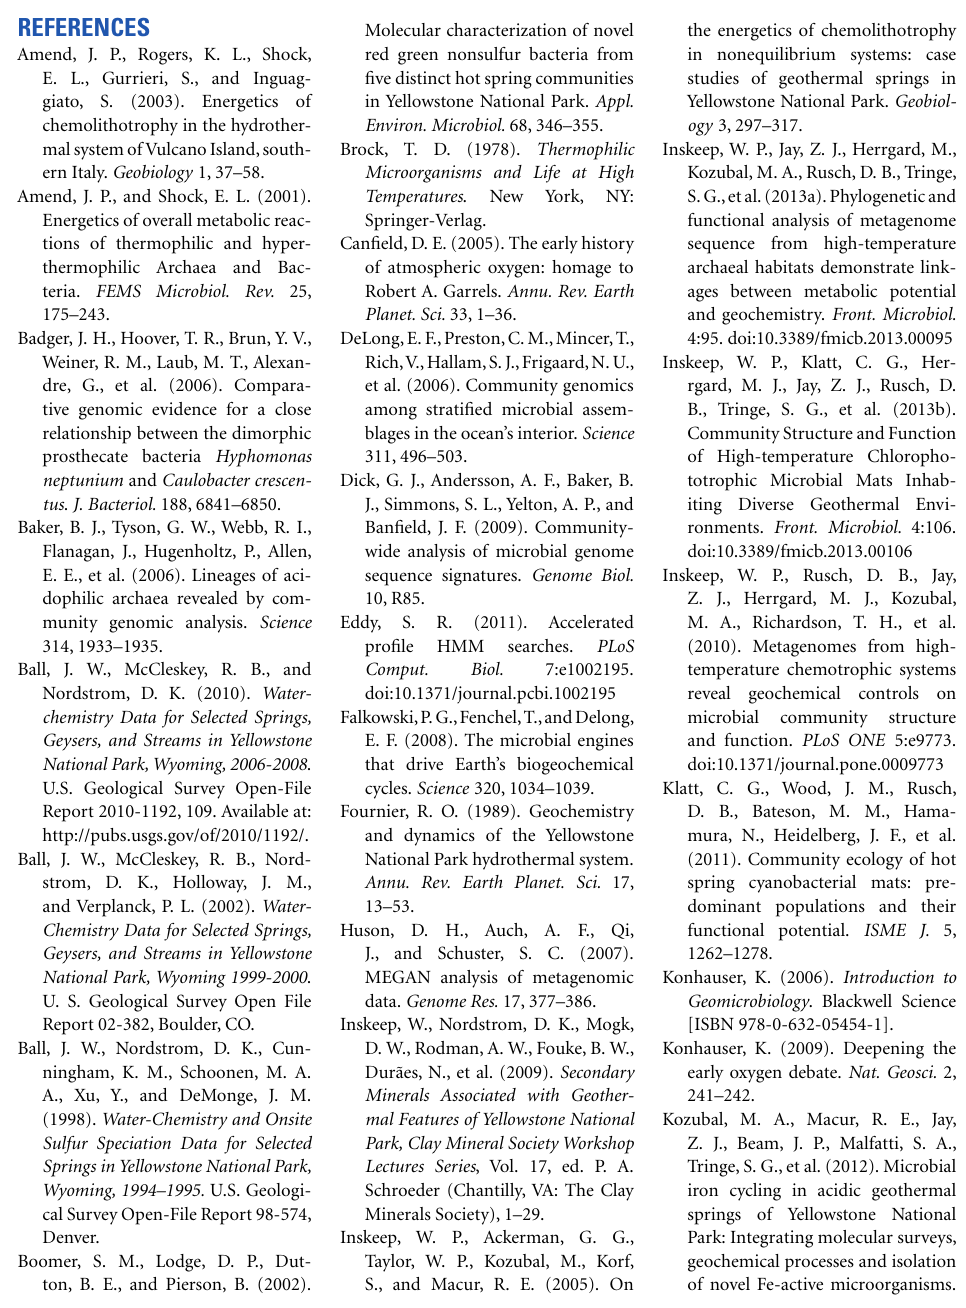
and phototrophic mats (green). (A) Signal transduction; (B) Regulatory functions (ANOVA test with Benjamini-Hochberg FDR multiple testing correction). Figure S3 | Principal components analysis of normalizedTIGRFAM protein family abundance data across all 20 sites as well as a subset of diverse metagenomic datasets from IMG. The metagenomes are colored based on rough classification of the environments from which the sample originates: Yellowstone sites in this study = red; Yellowstone sites from other studies = orange; sediments = turquoise; soils = pink; aquatic = light-blue; fungus-garden = green; animal-gut = brown; enrichment community = light-orange; other samples =